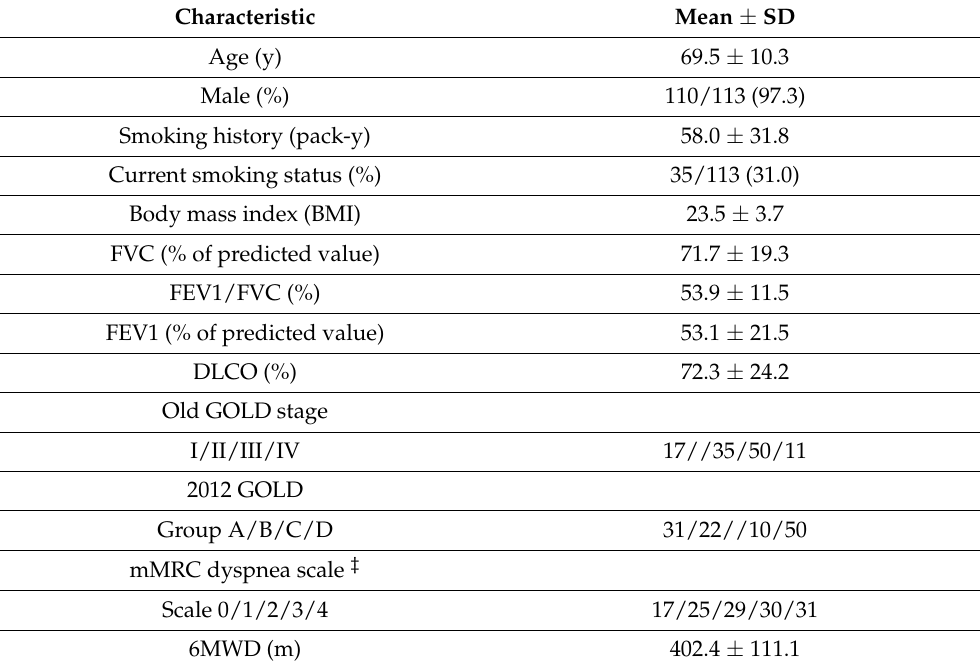
Table 1. Basic clinical characteristics of 113 patients with stable chronic obstructive pulmonary